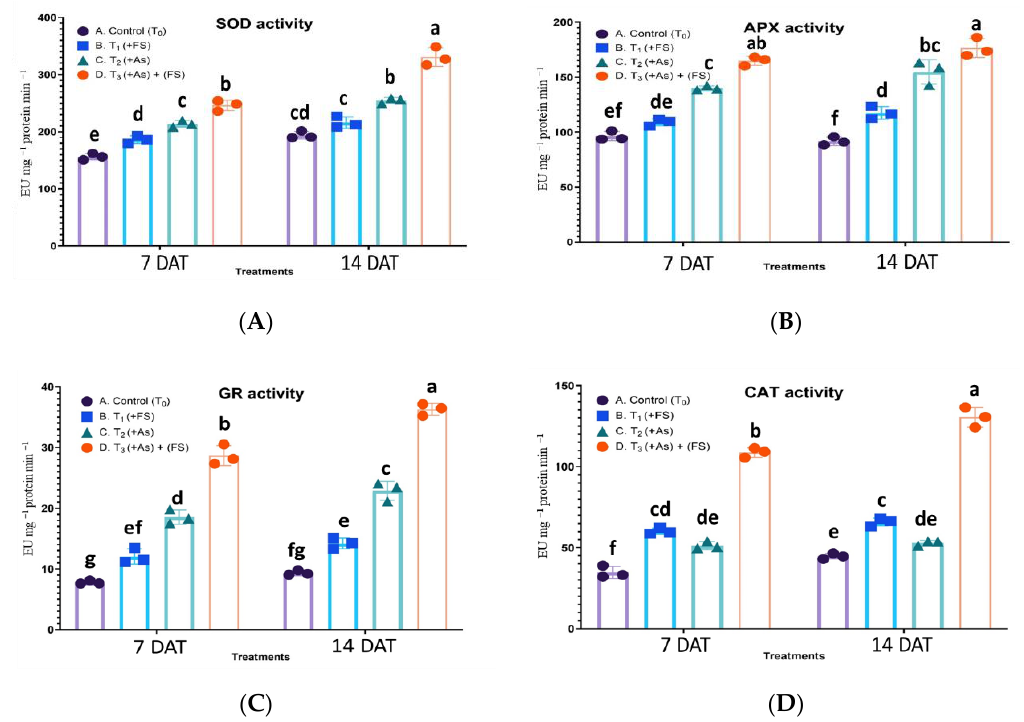
Figure 6. ( A – D ): Impact of iron sulfate (T 1 : +FeSO 4 ), arsenic stress (T 2 : +As) and iron sulfate supplementation during As stress (T 3 : As+FeSO 4 ) on the activity of Superoxide Dismutase (SOD, 6 A ), Ascorbate Peroxidase (APX, 6 B ), Glutathione Reductase (GR, 6 C ) and Catalase (CAT, 6 D ) in the leaf of Brassica juncea studied 7 and 14 days after treatment (DAT). The values are mean ± SE and n = 3. Different letters on the bars indicate significant changes ( p < 0.05) in different treatments as determined by Tukey’s HSD test. As, Arsenic; FS, FeSO 4 .